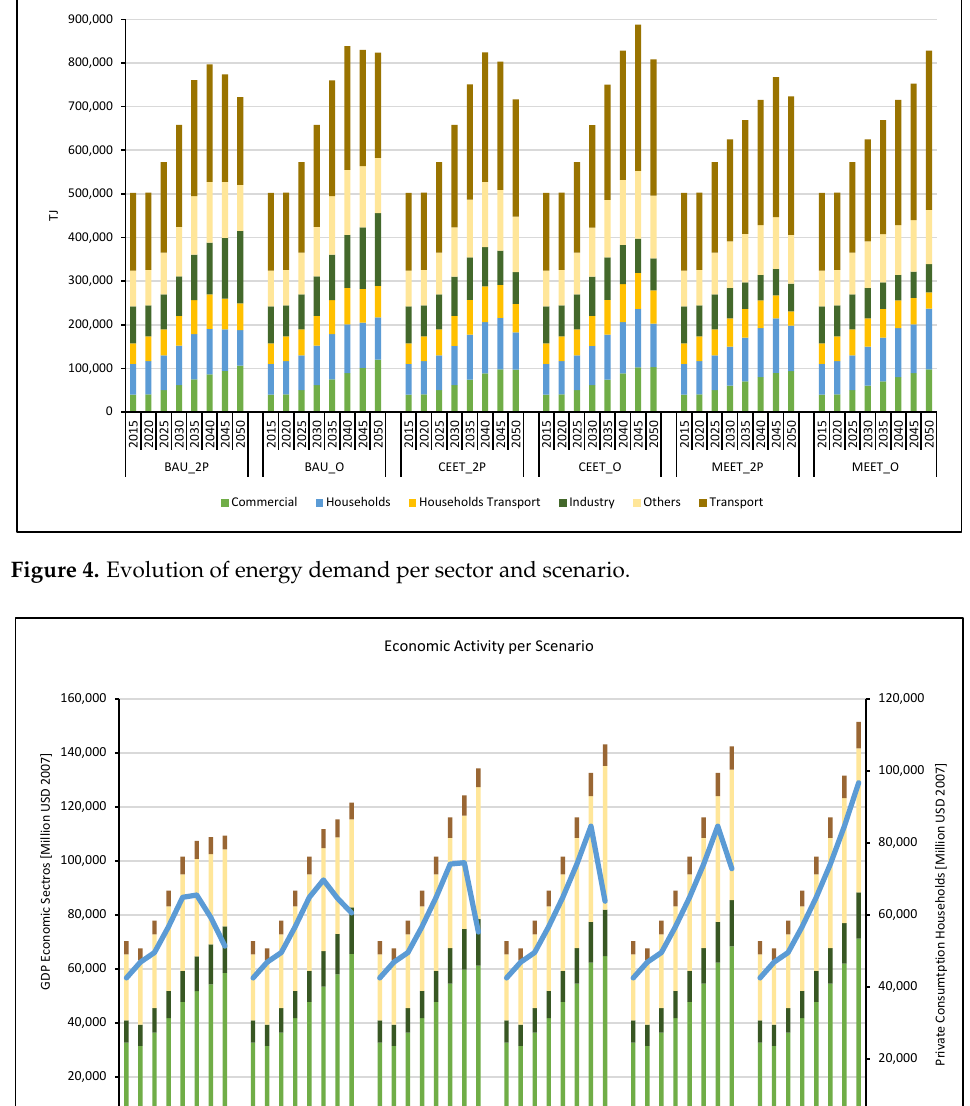
Figure 6. Evolution of energy intensity per sector and scenario.